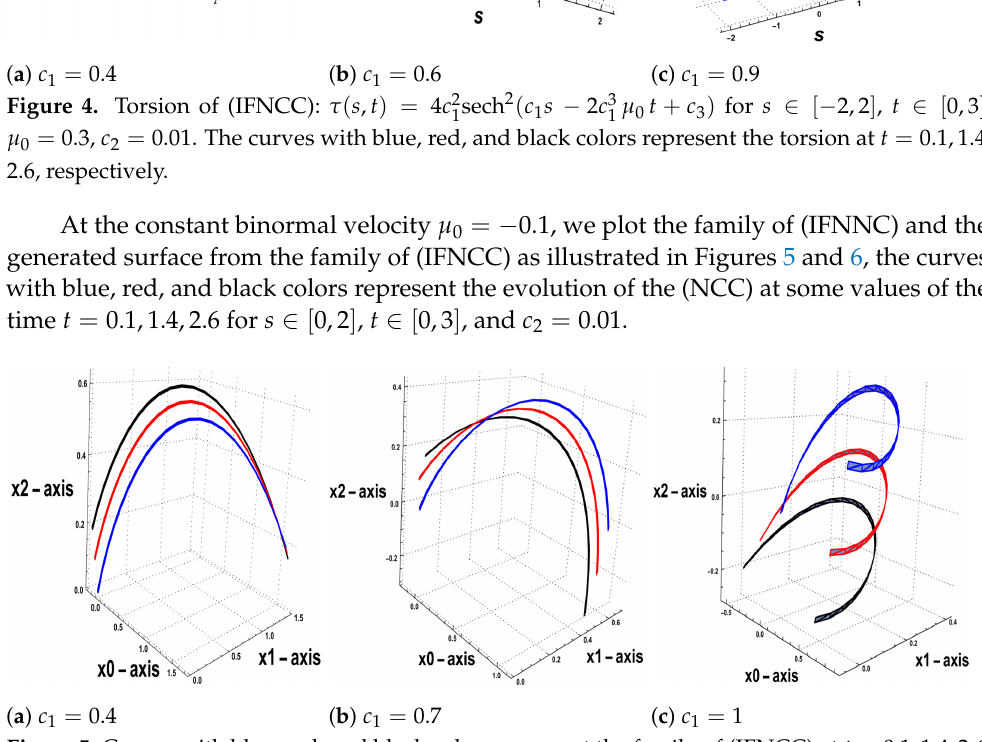
Figure 5. Curves with blue, red, and black colors represent the family of (IFNCC) at t = 0.1,1.4,2.6, respectively, for s ∈ [ 0,2 ] , t ∈ [ 0,3 ] , µ 0 = − 0.1, c 2 =